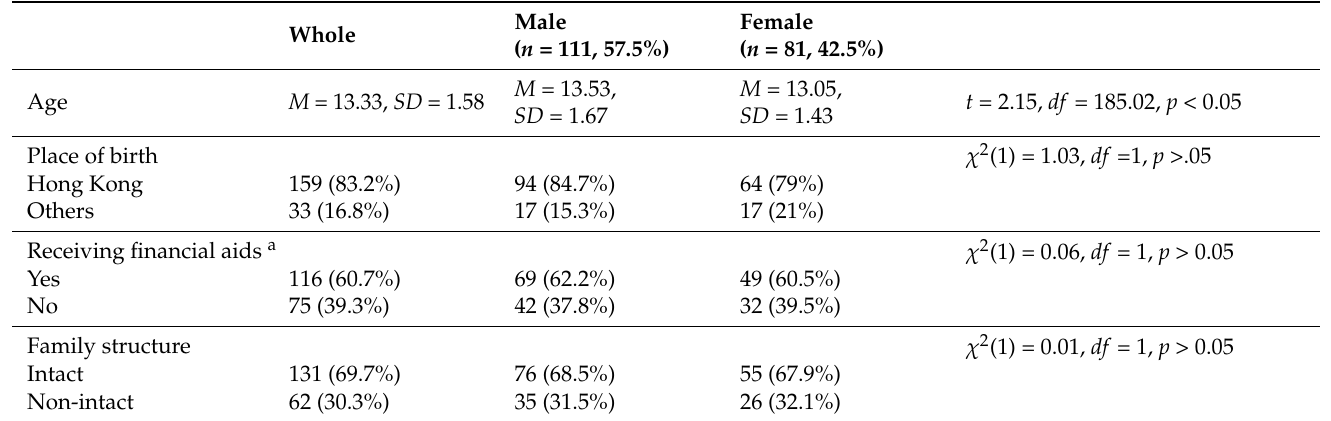
Table 1. Demographic background of the